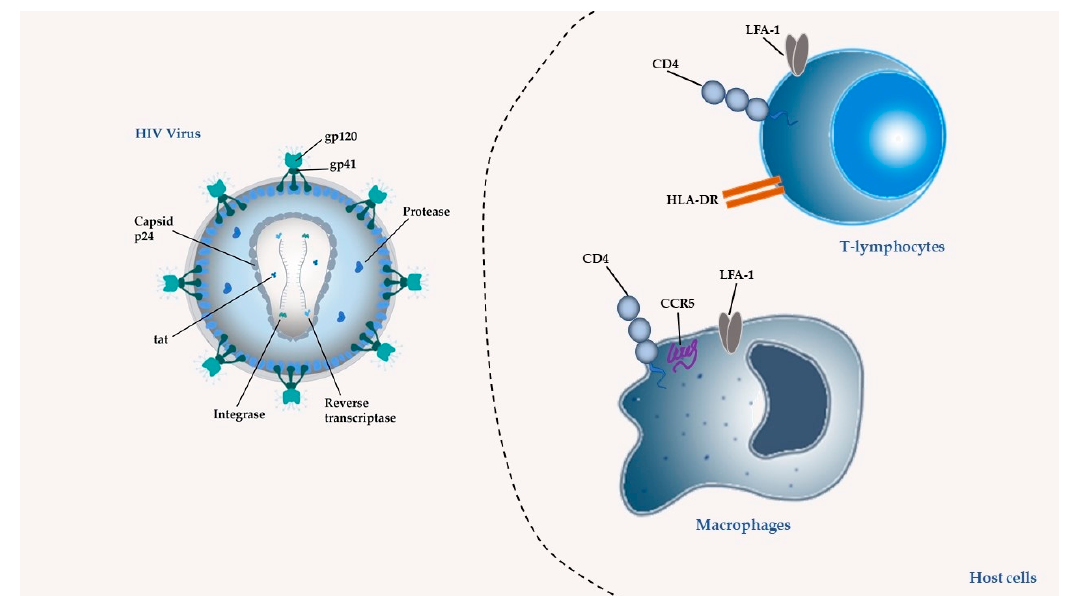
Figure 2. Molecular components of HIV virus and targets of ARV drugs. In the virus, the targets can be the glycoproteins responsible for adhesion gp120 and gp41; the enzymes integrase, reverse transcriptase, and protease; the protein from the capsid p24 and protein Tat that modulates transcription initiation and can reactivate a latently infected cell by penetrating. In the host cells the targets can be the lymphocyte function ‐ associated antigen 1 (LFA ‐ 1); the CD4 receptor and its co ‐ receptor C ‐ C Motif Chemokine Receptor 5 (CCR5); and the human leucocyte antigen (HLA ‐ DR).